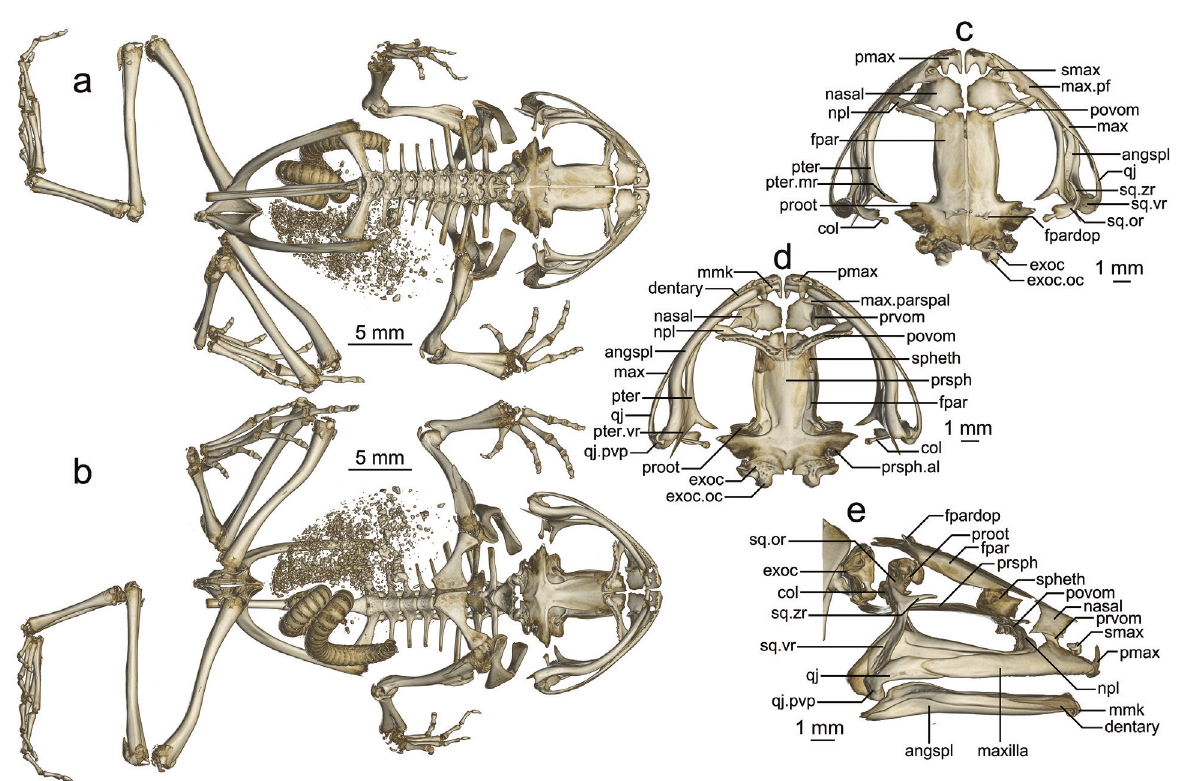
Figure 7. The skeleton of Plethodontohyla laevis (SMF 4286) rendered via micro-CT scanning. ( a–b ) Full skeleton in ( a ) dorsal and ( b ) ventral view. ( c–e ) Skull in ( c ) dorsal, ( d ) ventral and ( e ) lateral view. Abbreviations: angspl, angulosplenial; col, columel- la; exoc, exoccipital; exoc.oc, occipital condyle of exoccipital; fpar, frontoparietal; fpardop, frontoparietal dorsal process; max, maxilla; max.pf, pars facialis of maxilla; max.parspal, pars palatina of maxilla; mmk, mentomeckelian; npl, neopalatine; pmax, premaxilla; povom, postchoanal vomer; proot, prootic; prsph, parasphenoid; prsph.al, alary process of parasphenoid; prvom, pre- choanal vomer; pter, pterygoid; pter.mr, medial ramus of pterygoid; pter.vr, ventral ramus of pterygoid; qj, quadratojugal; qj.pvp, posteroventral process of quadratojugal; smax, septomaxilla; sq.or, otic ramus of squamosal; sq.vr, ventral ramus of squamosal; sq.zr, zygotic ramus of squamosal; spheth, sphenethmoid. For a 3D rotational model, see Suppl. material